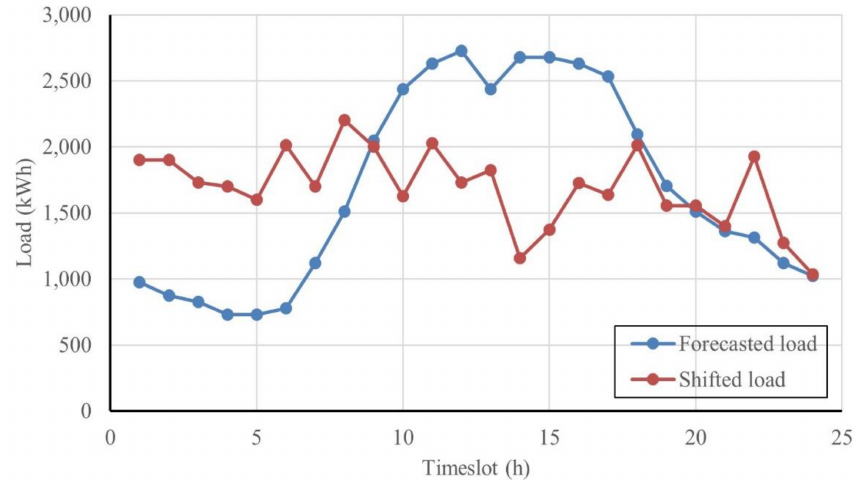
Figure 13. Hourly industrial load before and after DSM using the distributed algorithm RTP-PSO.